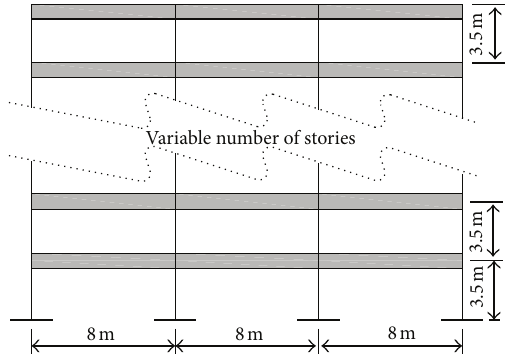
Figure 1: Geometrical characteristics of the frames.